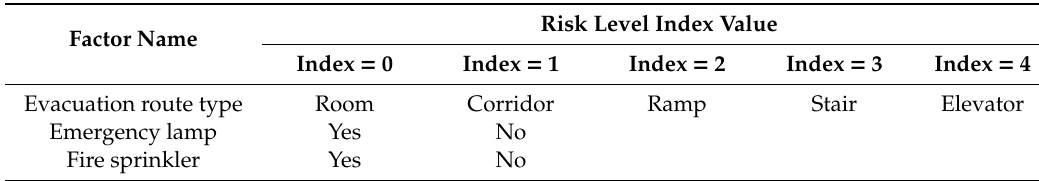
Table 3. Factors related to building and their index